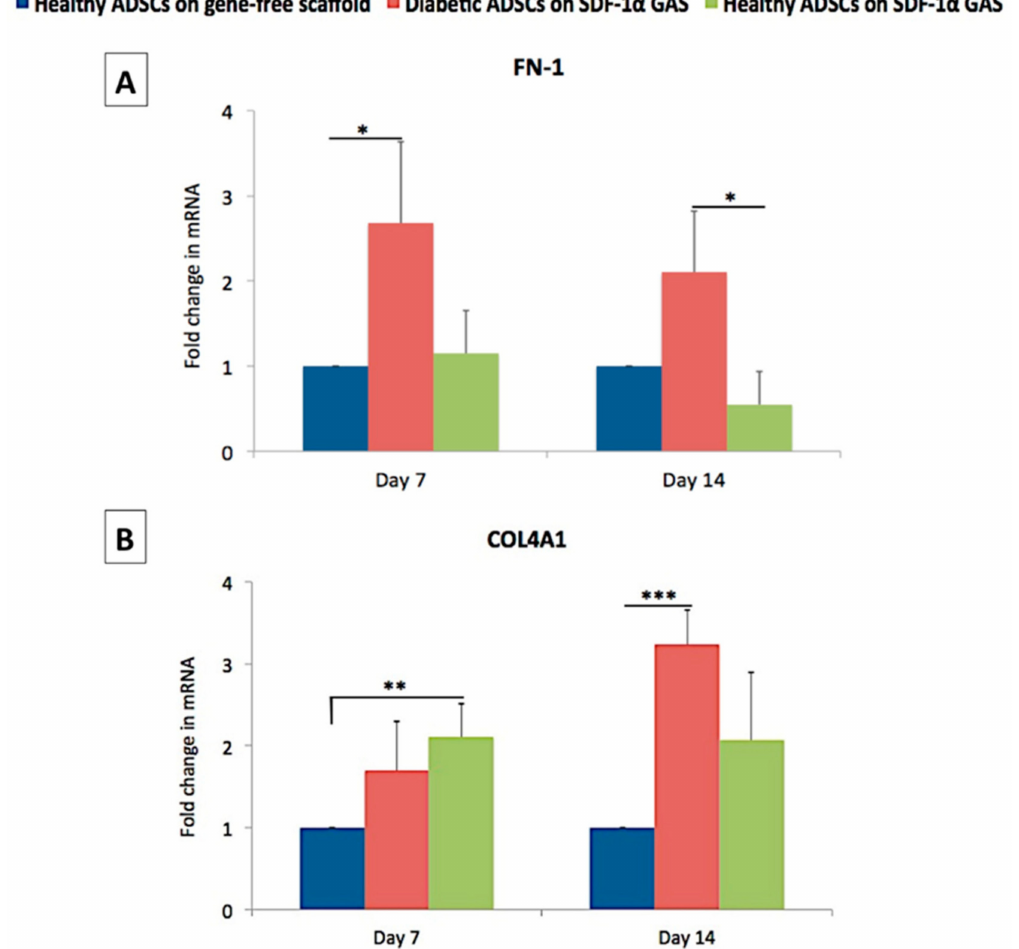
Figure 5. Effect of SDF-1 α gene-activated scaffold on the expression of pro-wound healing matrix genes in healthy and diabetic ADSCs. ( A ) On day 7, the transfected diabetic ADSCs on the gene-activated scaffold showed a significantly ( p < 0.05) enhanced transcription of the FN1 gene than the healthy ADSCs on the gene-free scaffold. ( B ) At the same time point, the healthy ADSCs on the gene-activated scaffold showed a significant activation of the COL4A1 gene than their gene-free equivalent. *, ** and *** indicate statistical significance at p < 0.05, p < 0.01 and p < 0.005, respectively. Data are presented as mean ± standard deviation ( n =